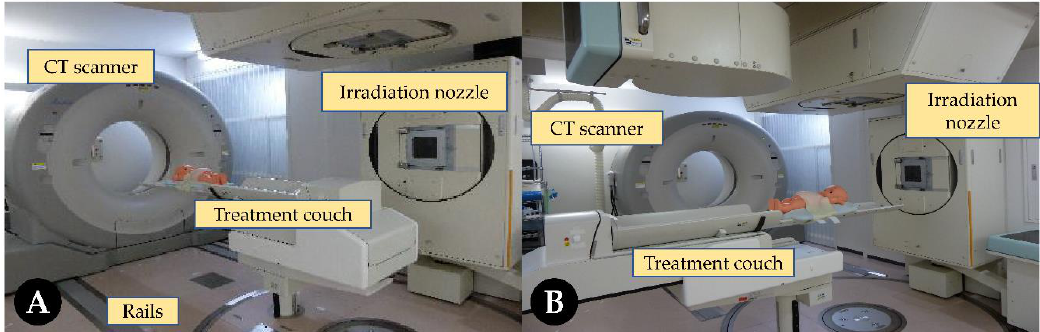
Figure 4. Carbon ion facility with in-room computed tomography (CT) by Hitachi and Canon Medical Systems. The treatment couch is moved for CT scanning ( A ) and then moved back for radiotherapy ( B ).